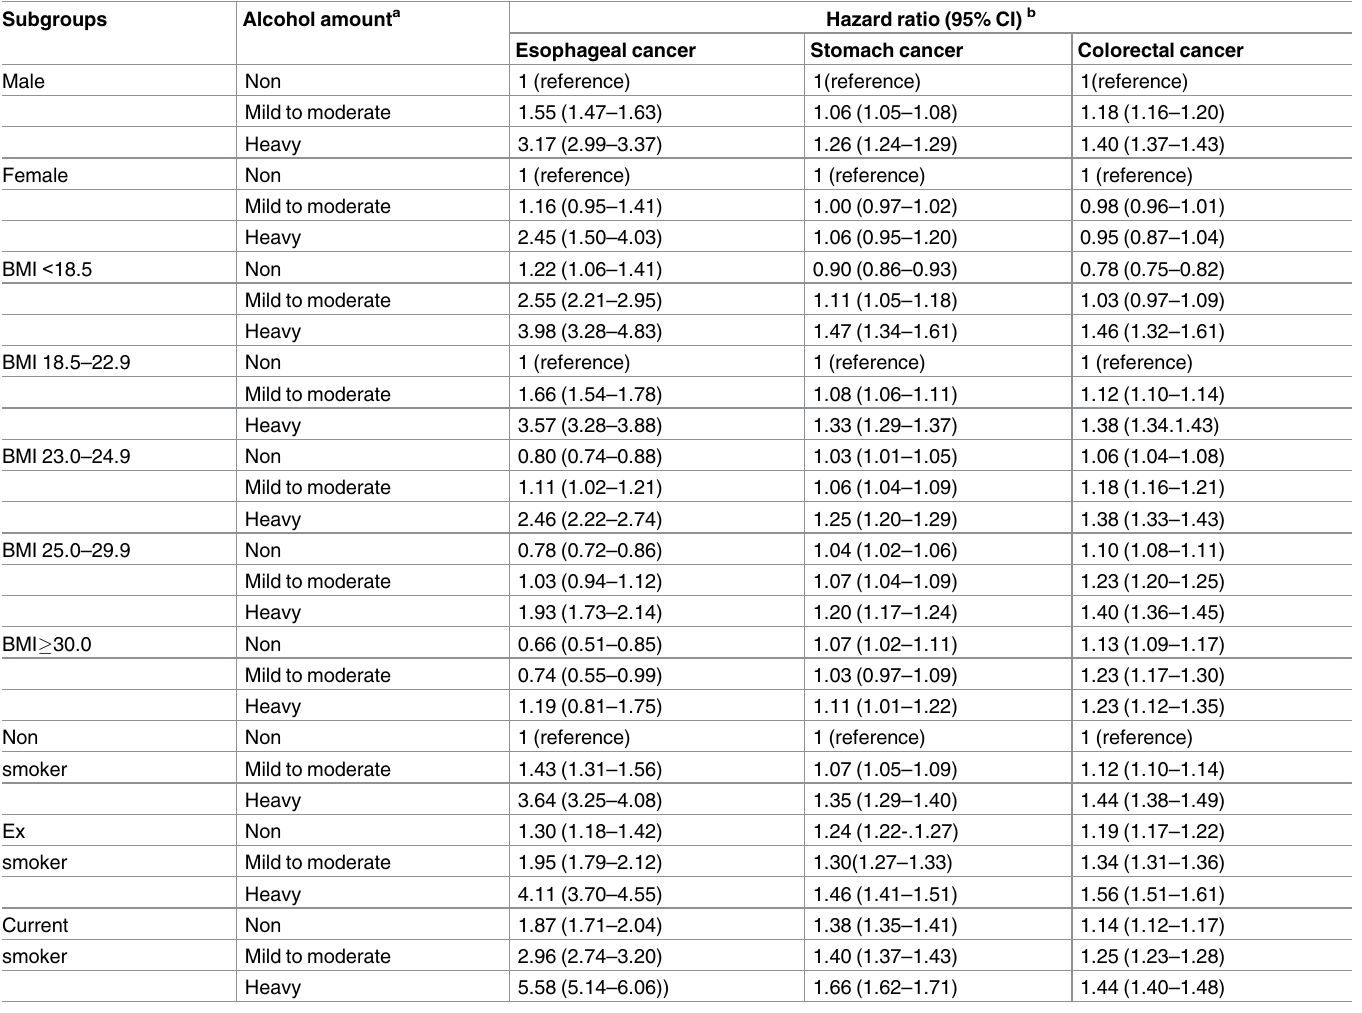
Table 3. Subgroup analysis of the risk of esophageal, stomach and colorectal cancersaccording to alcohol consumption.